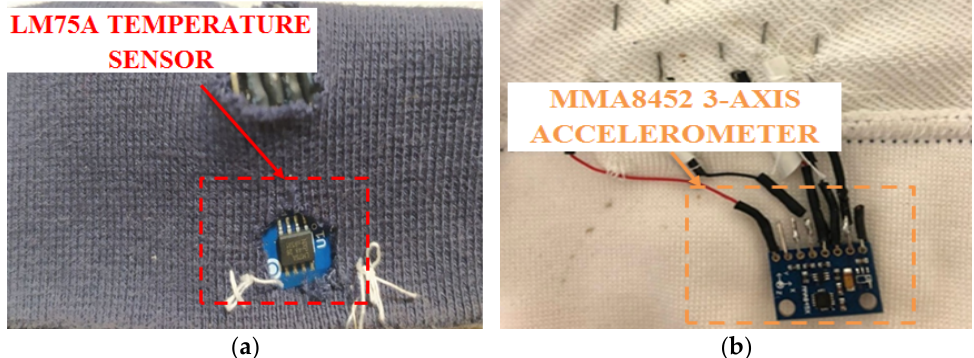
Figure 8. LM75A temperature sensor placed outside the pocket created in the left cuff ( a ); MMA8452 accelerometer on the lower part of the sweatshirt ( b ).